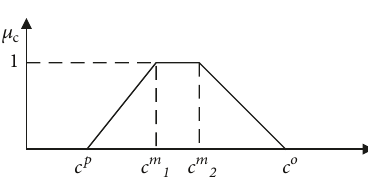
Figure 2: The trapezoidal possibility distribution of fuzzy number ̃𝑐